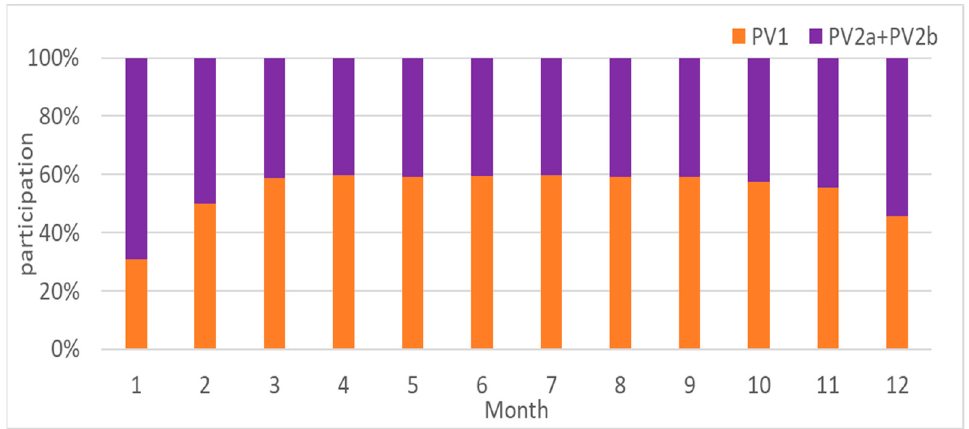
Figure 19. Share of PV1 and PV2a+PV2b sections in monthly generation of PV1 and PV2a+PV2b sections in 2021 (own measurement data).